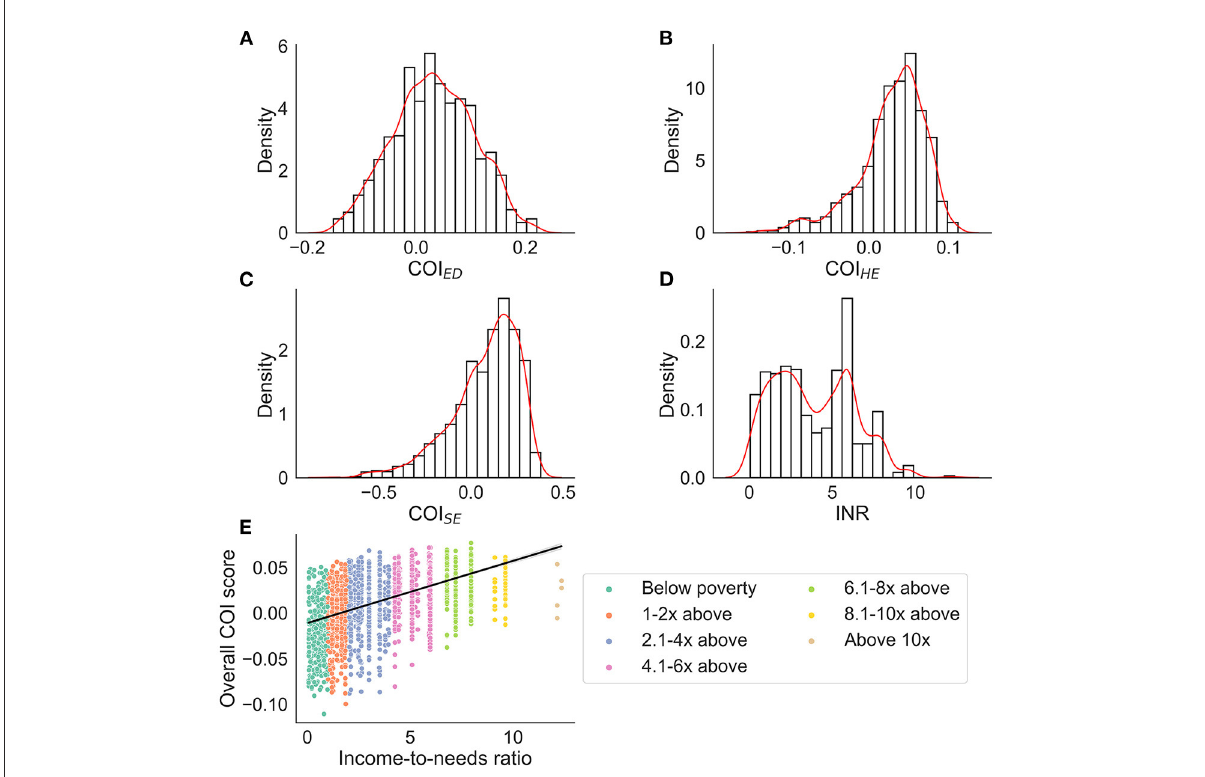
FIGURE1 Distributions for each COI domain (nationally normed and z-score transformed) and income-to-needs ratio (INR). For (A–D) density (i.e., probability generated from the Kernel Density Estimation) is plotted on the y-axis. The red line represents a smoothed distribution. (E) The overall COI score binned by income-to-needs ratio to represent how many youth were below or above the poverty line. ED, education domain; HE, health/environmental domain; SE, social/economics domain.